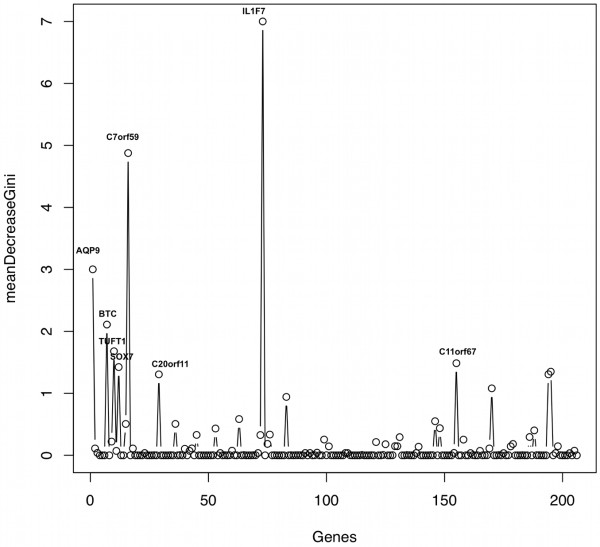
Informative genes for the classification of skin samples in lesional and non-lesional classes (PP and PN, respectively). Gini Index (GI) was used to generate a variable importance measure and provide an estimate of feature (gene) relevance to disease state. The five most important genes in determining disease classes were IL1F7, C7orf59, AQP9, BTC and TUFT1.